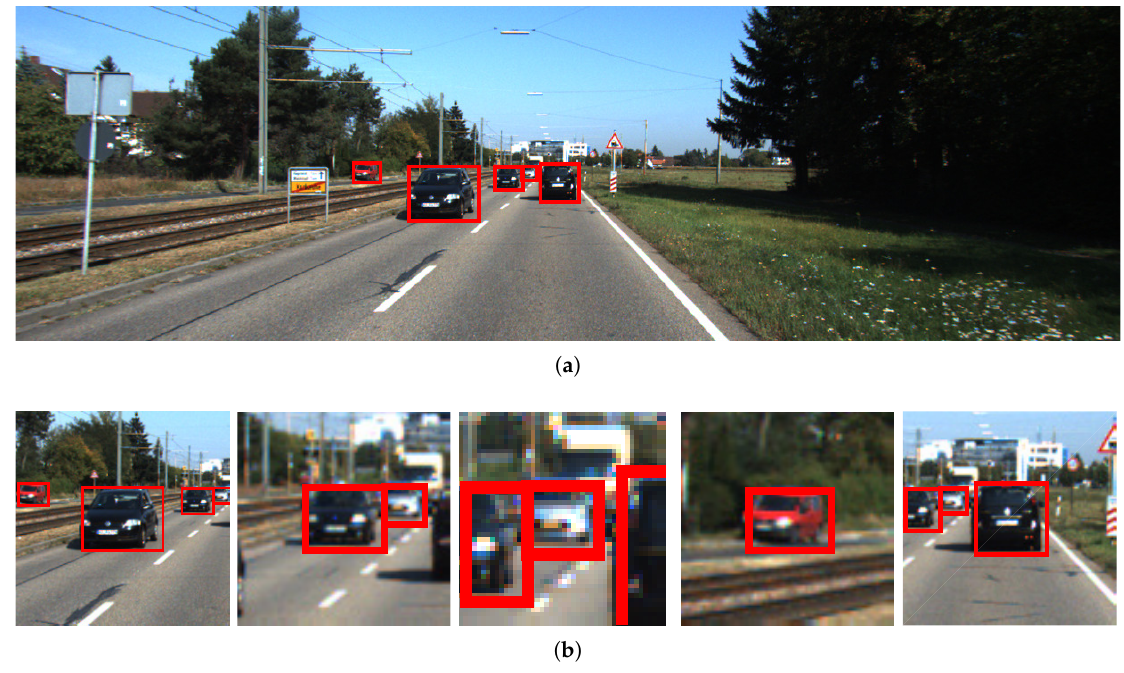
Figure 2. ( a ) The original image with ground-truth bounding boxes overlaid on it; and ( b ) the cropped patches around the object ROIs.